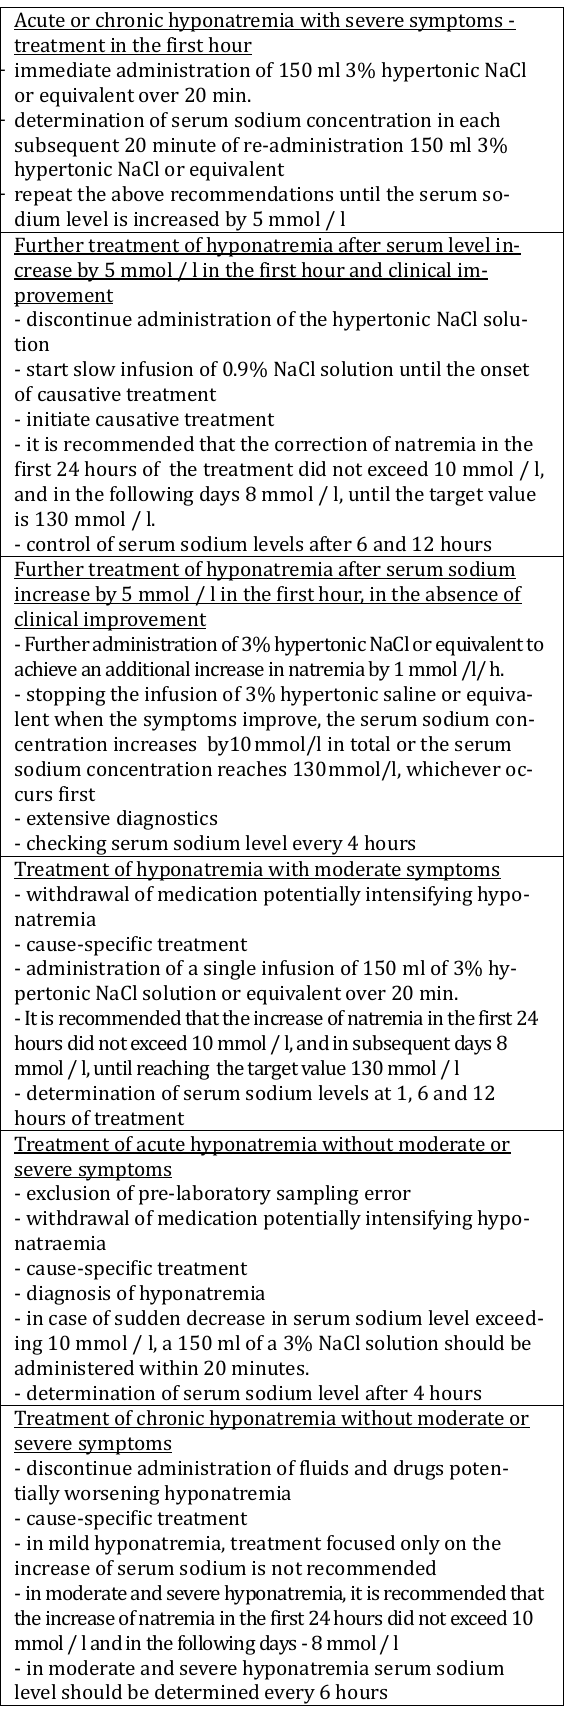
Table 6. SIADH treatment (adapted from: Spasovski, G. et al. [5]) Acute or chronic hyponatremia with severe symptoms - treatment in the first hour - immediate administration of 150 ml 3% hypertonic NaCl or equivalent over 20